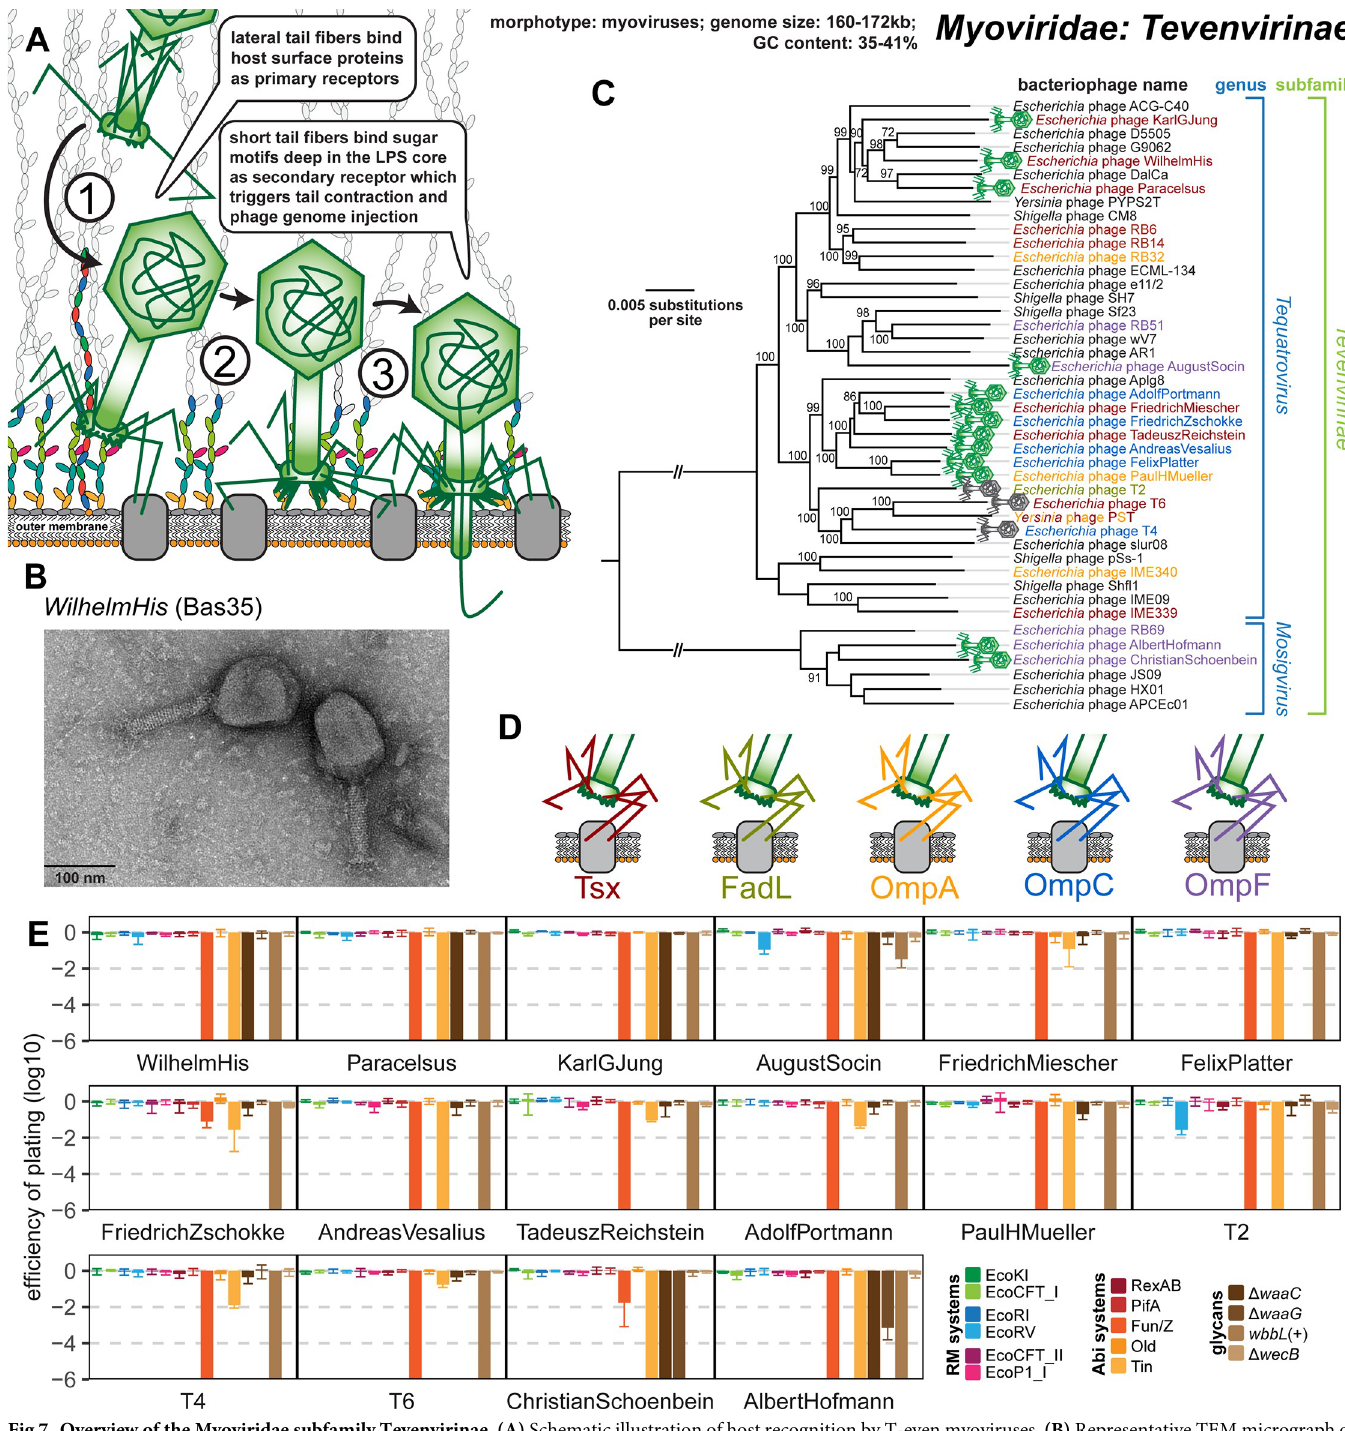
Fig 7. Overview of the Myoviridae subfamily Tevenvirinae. (A) Schematic illustration of host recognition by T-even myoviruses. (B) Representative TEM micrograph of phage WilhelmHis (Bas35). (C) Maximum-Likelihood phylogeny of the Tevenvirinae subfamily of Myoviridae based on a curated whole-genome alignment with bootstrap support of branches shown if > 70/100. The phylogeny was rooted between the Tequatrovirus and Mosigvirus genera. Phages of the BASEL collection are highlighted by little phage icons and experimentally determined primary receptor specificity is highlighted at the phage names using the color code highlighted in (D). Primary receptor specificity of T-even phages depends on RBPs expressed either as a C-terminal extension of the distal half fiber (T4 and other OmpC-targeting phages) or as separate small fiber tip adhesins [65], but sequence analyses of the latter remained ambiguous. We therefore only annotated experimentally determined primary receptors (see also S4A Fig) [51,65]. (D) Color code of primary receptor specificity. (E) The results of quantitative phenotyping experiments with Tevenvirinae phages